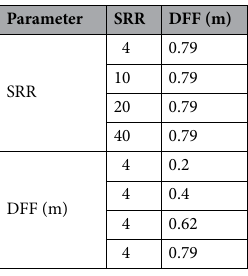
Table 6. Parameter settings.